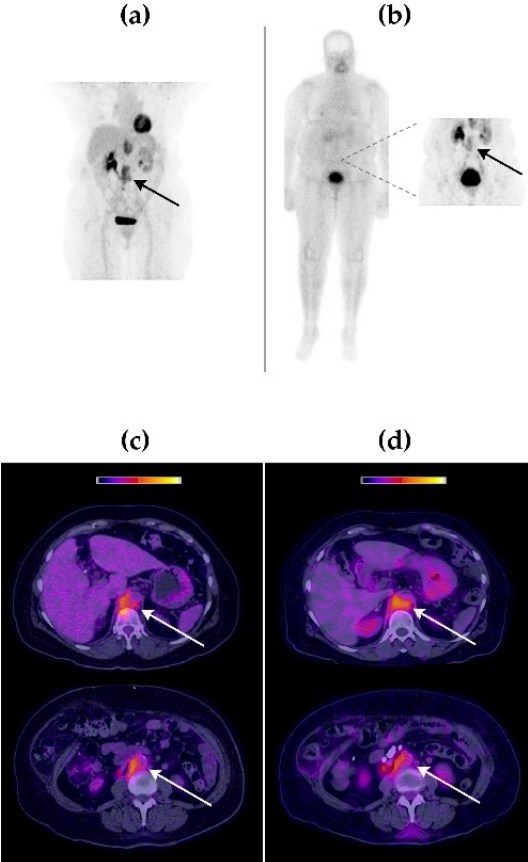
Figure 5. Patient with cervical squamous cell carcinoma and retroperitoneal lymph node recurrence (Patient 3). ( a ) Maximum-intensity projection [ 18 F]FDG PET image at 1 h p.i. ( b ) [ 99m Tc]Tc-iFAP whole-body planar scintigraphy in anterior projection. Inset: abdominal SPECT at 3 h p.i. ( c ) [ 18 F]FDG PET/CT axial sections. ( d ) [ 99m Tc]Tc-iFAP SPECT/CT axial sections. Lymph node conglomerates at the right retrocrural and retroperitoneal intercaval-aortic level with retrocaval extension. No recurrent primary lesion was observed at the pelvic level. The uptake of both radiopharmaceu ‐ ticals was concordant in all tumor lesions.